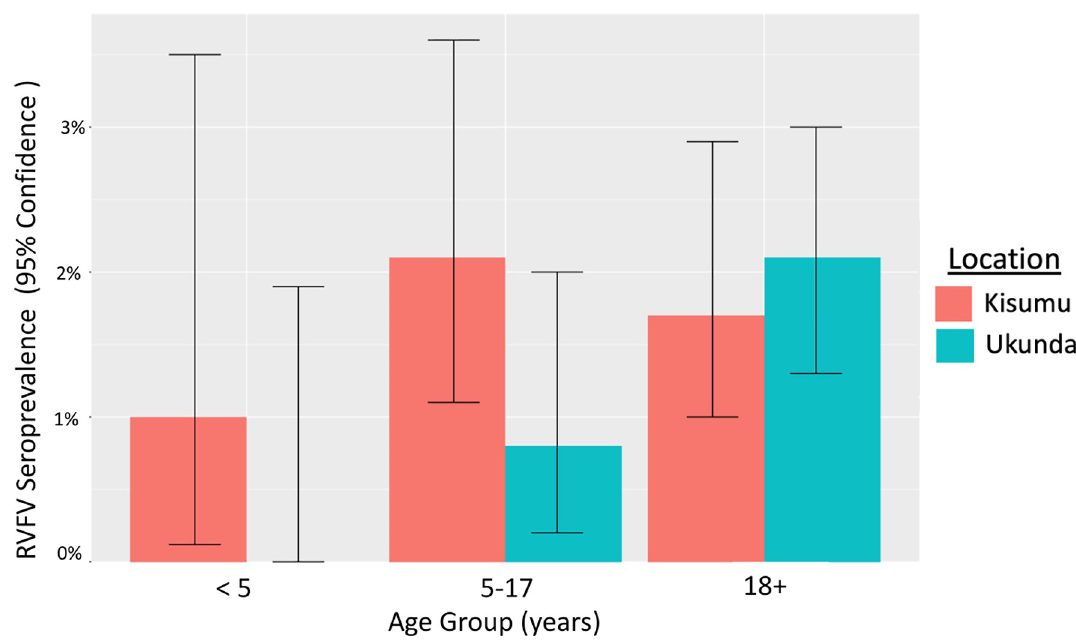
Fig 3. RVFV IgG seropositivity by age group and location.